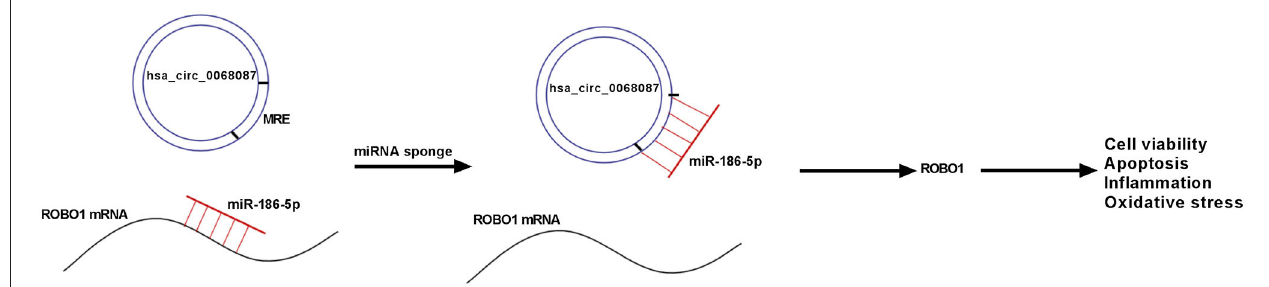
FIGURE 7 | Diagram of the working mechanism of circ_0068087 in ox-LDL-induced